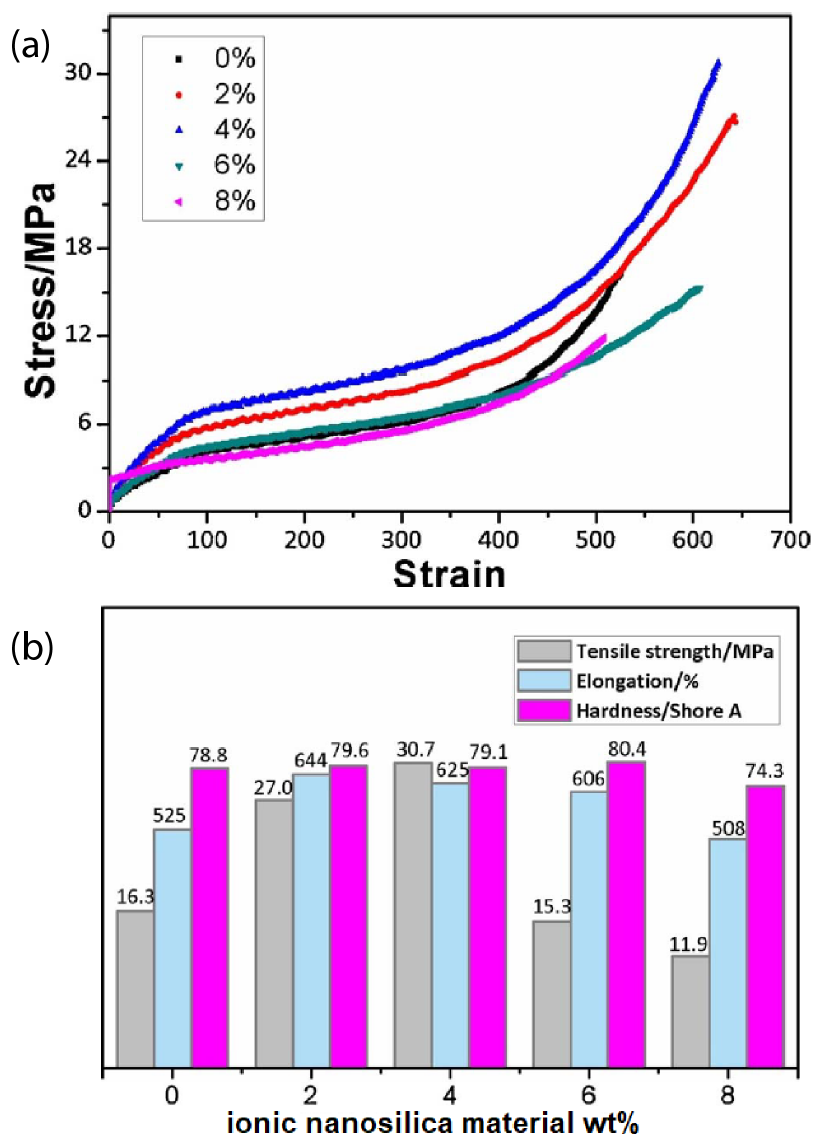
Figure 10. ( a ) Stress strain curves of PU/ ionic nanosilica hybrids, ( b ) Mechanical properties of PU/ ionic nanosilica hybrids. Reprinted with permission from He et al.